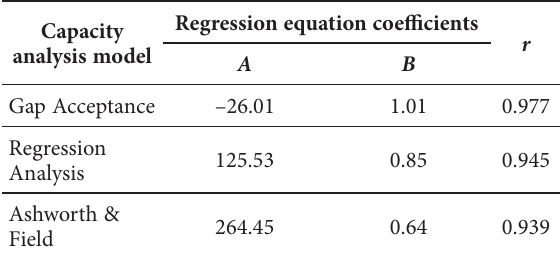
Table 3. Comparison of capacity models and observed data